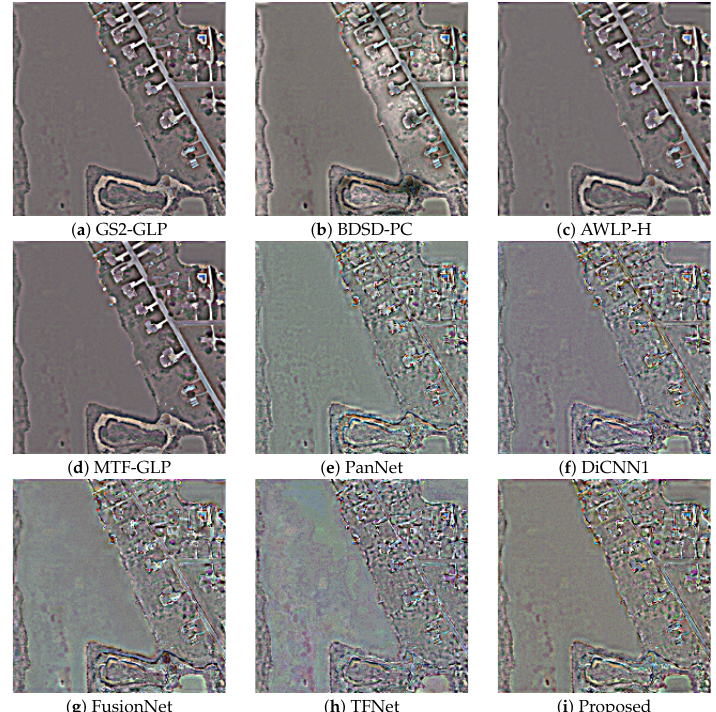
Figure 5. Residual images of fusion results shown in Figure